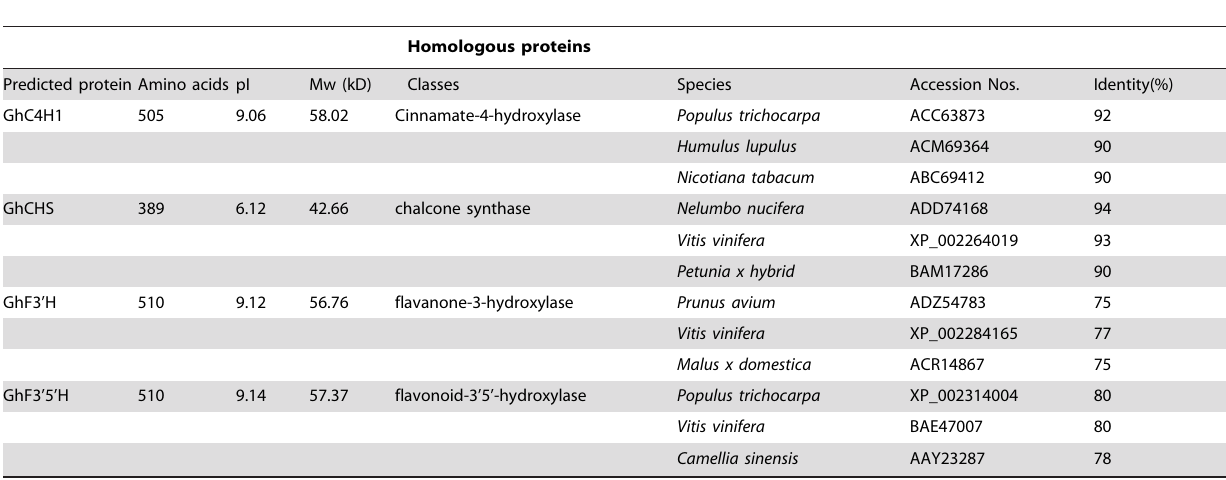
Table 2. The proteins encoded by the flavonoid structural genes and the sequence similarity to their homologs.